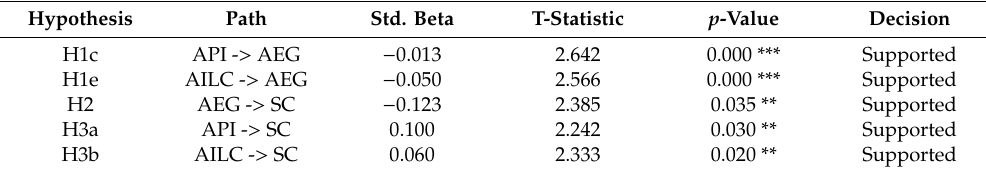
Table 4. Hypothesis testing of direct relationships.